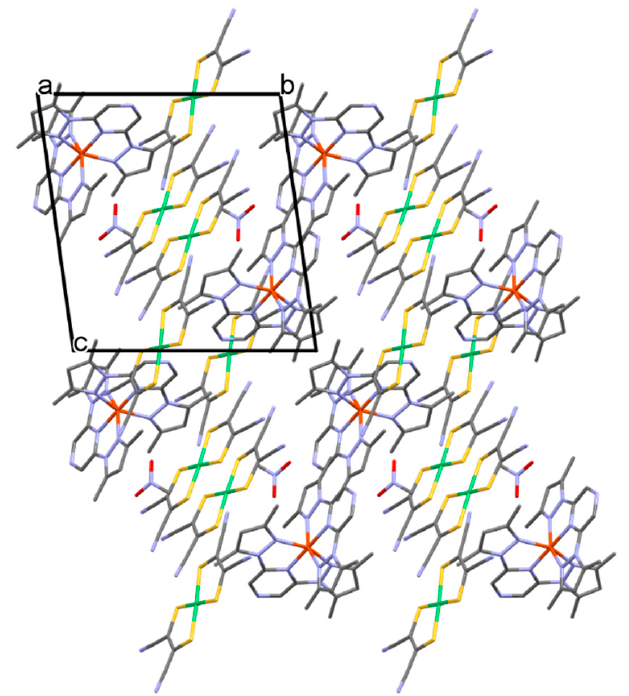
Figure 4. The crystal packing of compound 2 at 100 K. H atoms have been omitted for clarity.